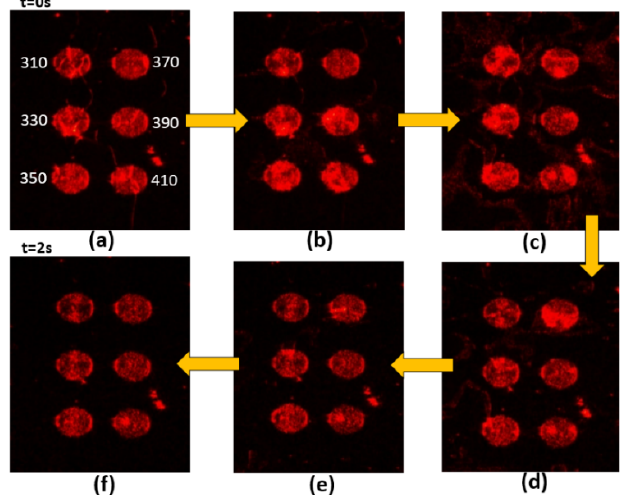
Figure 6. Sequential images from ( a ) to ( f ) illustrating transitional transmission through Al circular grating samples with pitches ranging from 310 nm to 410 nm. The pumping light is 405 nm. Liquid crystals are transformed from nematic phase to isotropic phase.